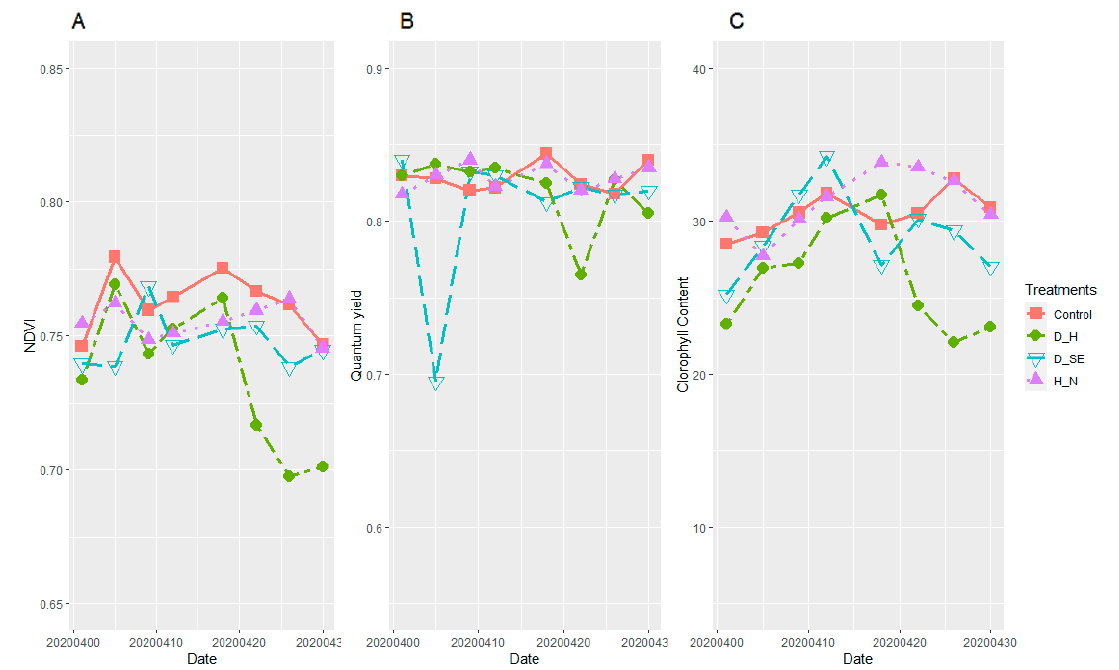
Figure 8. Plants development curves obtained with handheld sensors versus sampling dates (from stem elongation to grain filling stage), clustered based on their treatment forming four groups (control, drought at stem elongation (D_SE), drought at heading (D_H), and high nitrogen content (H_N). ( A ) Normalized difference vegetation index (NDVI); ( B ) quantum yield (QY); ( C ) chlorophyll content index (CC).